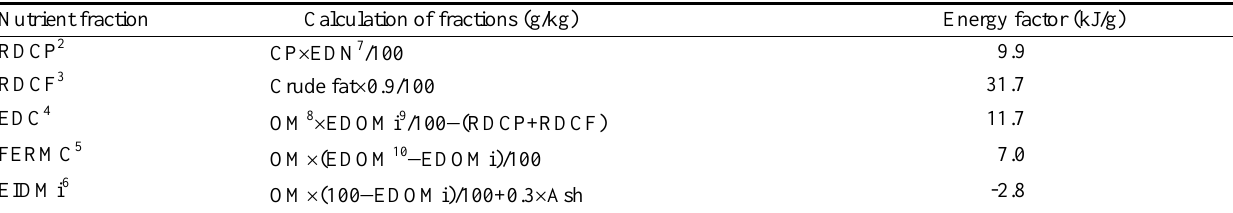
Table 3. Calculations of energy values for diets in the potential physiological energy (PPE) system 1 Nutrient fraction Calculation of fractions